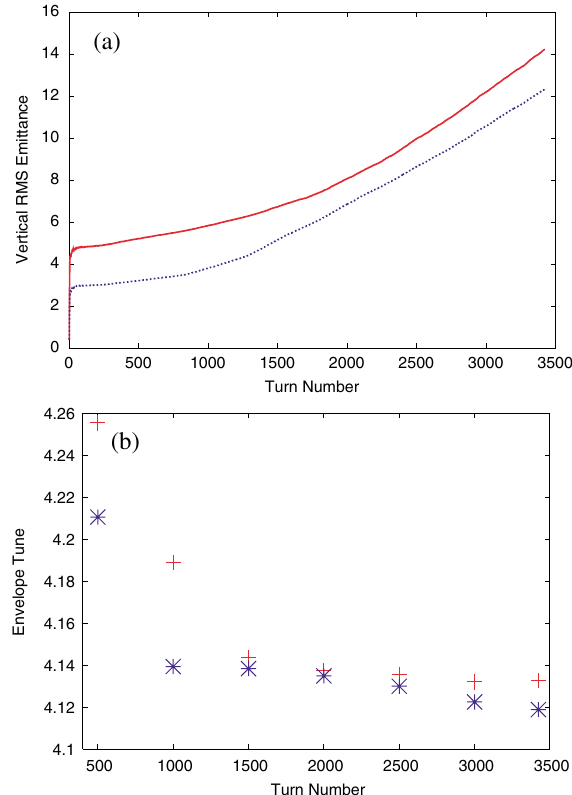
FIG. 24. (Color) Top panel: Simulated vertical rms emittances during the accumulation of a high intensity beam with two different injection painting schemes. The solid (red) curve represents the beam with a 17.51 mm injection offset, and the dashed (blue) curve represents the beam with a 12.61 mm injection offset. Bottom panel: Calculated envelope tune versus turn for the 17.51 mm injection offset (red +’s), and for the 12.61 mm injection offset (blue (cid:11) ’s).